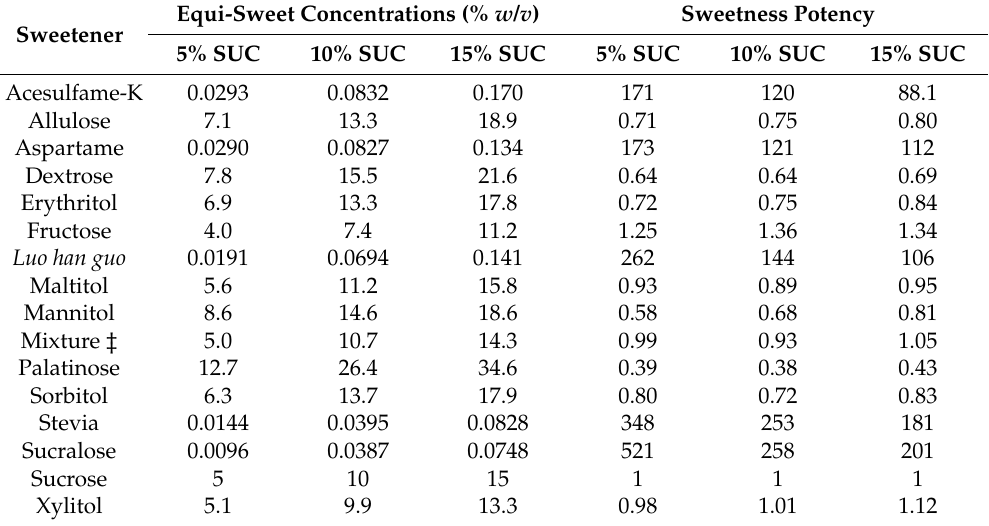
Table 4. Concentrations matching for equi-sweetness and sweetness potency of 15 sweeteners to 5%, 10% and 15% w / v